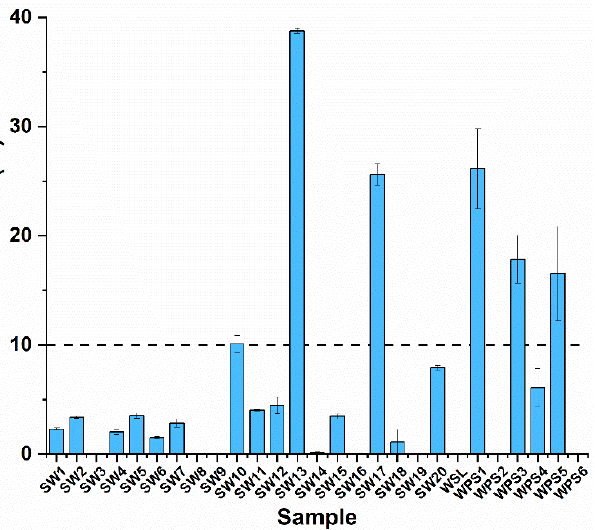
Figure 2. Acute toxicity of the samples determined by the inhibition of Vibrio fischeri with an expo- sure time of 30 min. SW1–SW20 show the surface water samples, among these, SW16–SW19 are adjacent to a goose farm. WSL is the sample collected from a water source reservoir, and WPS1–WPS6 are the samples collected from possible pollution sources.